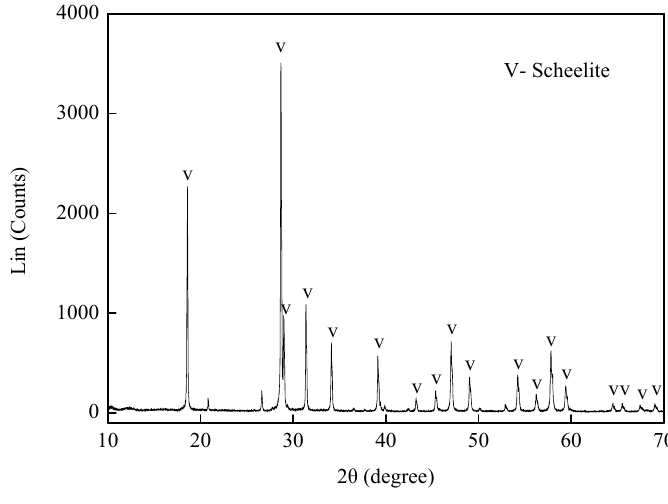
Figure 1. XRD of scheelite.